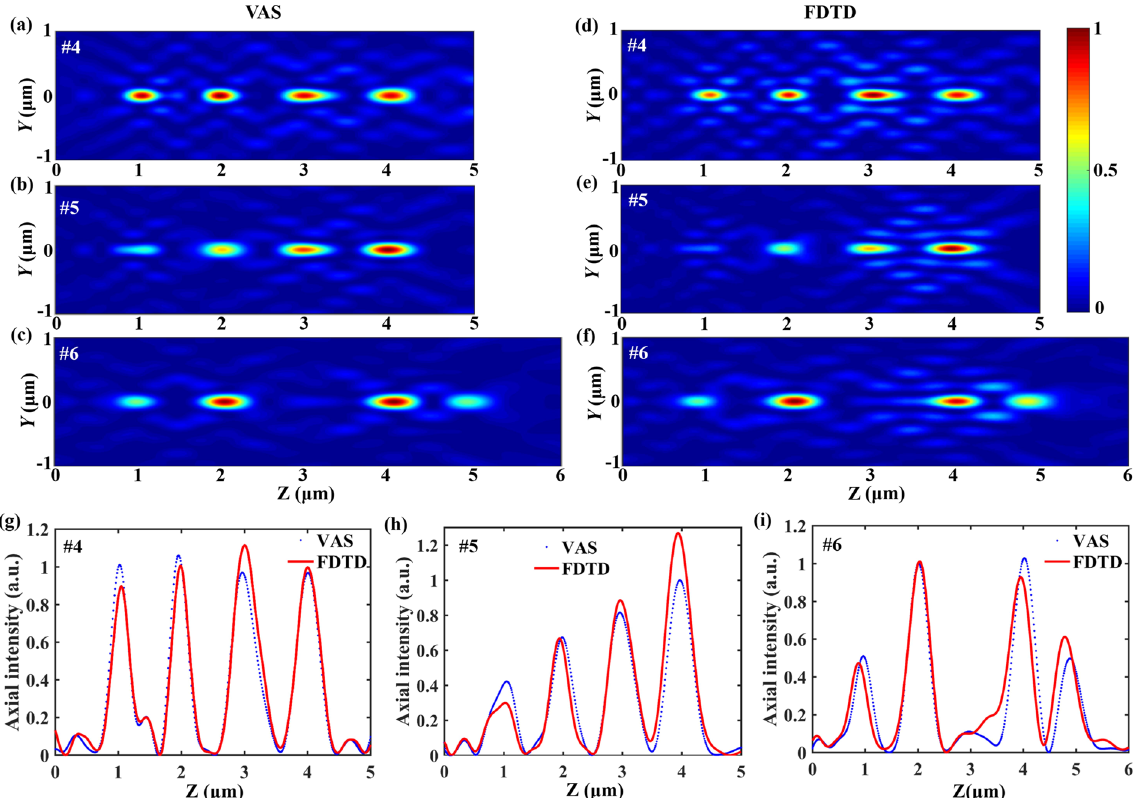
Figure 7. Comparison of the axial intensity distributions illuminated by LPB. ( a–c ) Show the normalized light intensity patterns of SOLs #4~#6 calculated by the VAS theory, respectively. ( d–f ) Show the normalized light intensity patterns of SOLs #4~#6 simulated by FDTD, respectively. ( g–i ) Show the comparison of the axial intensity distributions for SOLs #4~#6 calculated through the VAS theory (blue dot) and FDTD method (red solid line),